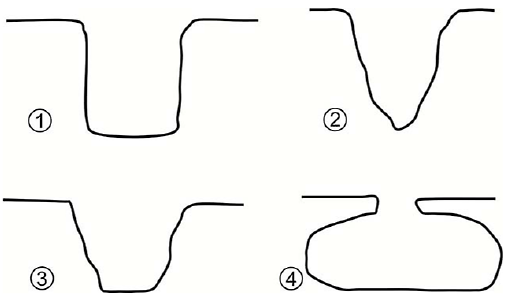
Fig. 9. Schematic sections of sinkhole-like features individuated in the Paganico area: (1) cylindrical, (2) conical, (3) truncated-conical, (4) barrel.